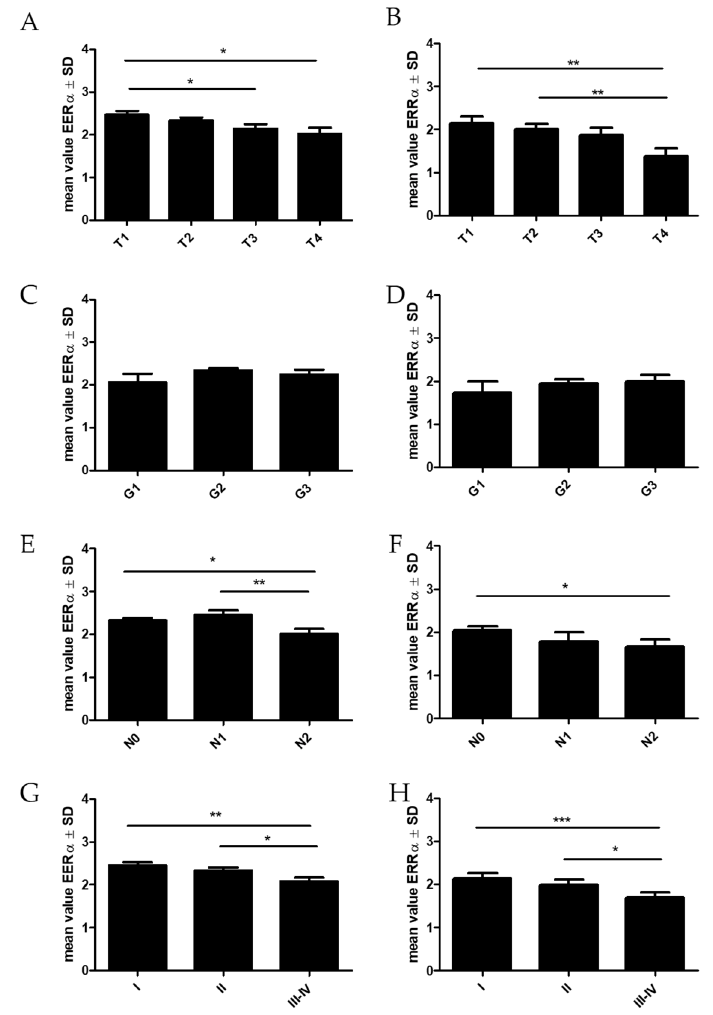
Figure 3. Comparison of ERR α receptor expression levels detected by immunohistochemistry (IHC) in non-small cell lung cancer NSCLC (n = 860, A , C , E , G ) and adenocarcinoma subtype—AC (n = 344, B , D , F , H ) according to the tumor size ( A , B ), the grade of malignancy ( C , D ), the lymph node status ( E , F ), and the tumor stage ( G , H ), * p ≤ 0.05, ** p ≤ 0.005, *** p ≤ 0.001. In the adenocarcinoma (AC) subtype, we observed similar tendencies to those in NSCLC. ERR α expression decreased in higher T (T1 vs. T4 p = 0.0061; T2 vs. T4 p = 0.0097) and N stages (N0 vs. N2 p = 0.0494). In this subtype of lung cancer, we also found that patients with higher ERR α expression had significantly longer OS times ( p = 0.0310) (Figure